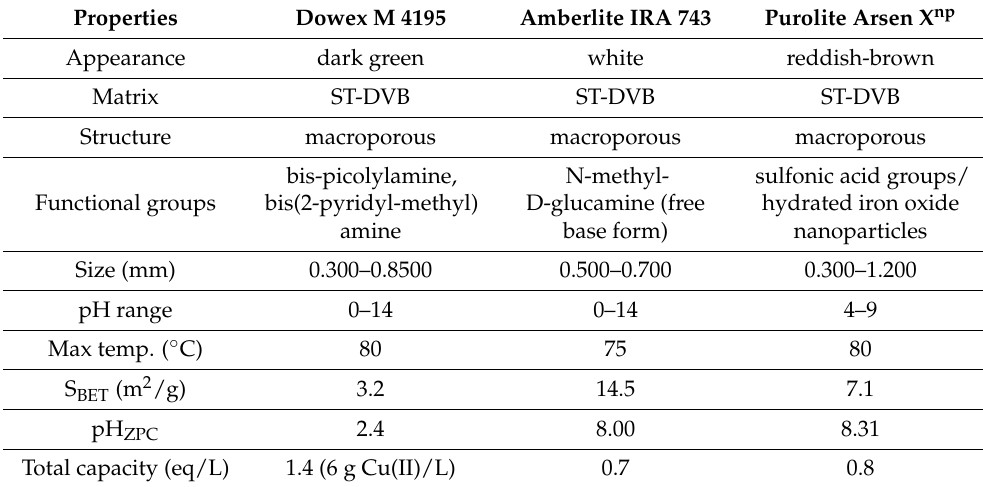
Table 1. Physicochemical properties of Dowex M 4195, Amberlite IRA 743 and Purolite Arsen X np